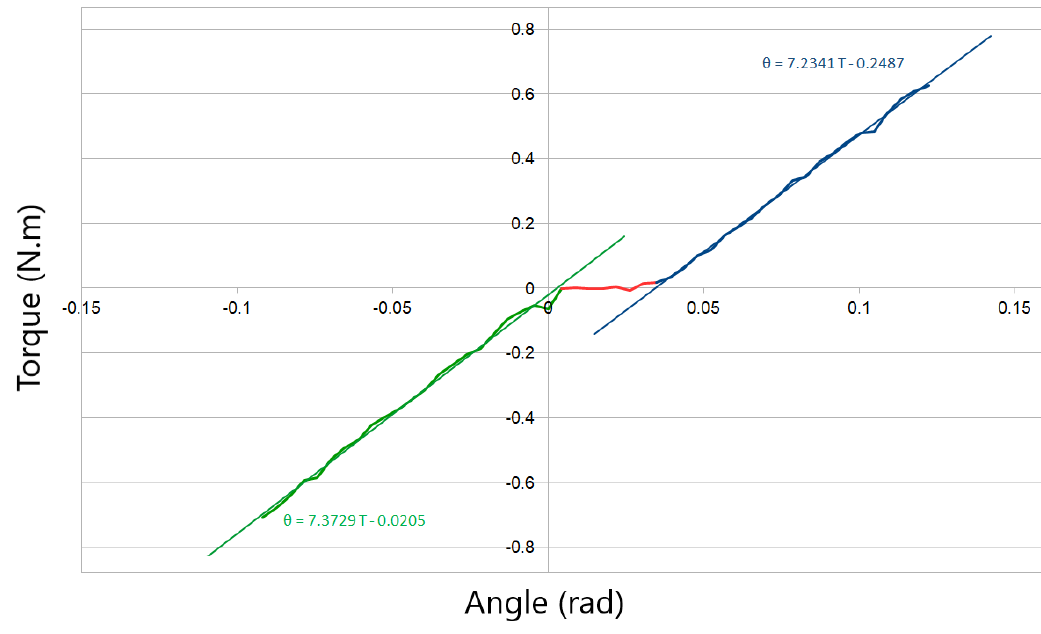
Figure 13. Plot of Torque vs.